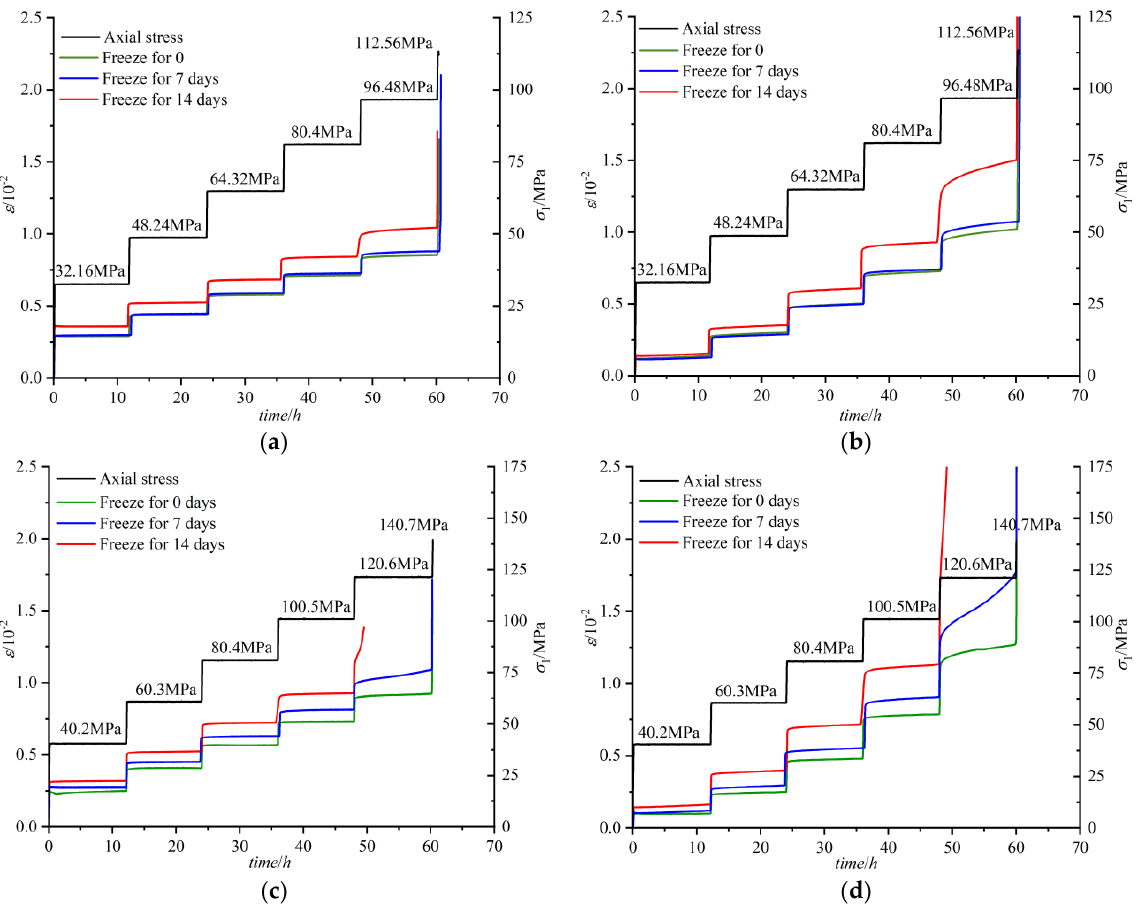
Figure 5. Loading creep curves for different confining pressure and different freezing periods (here, R15-0, R15-7, and R15-14 and R21-0, R21-7, and R21-14 are used to denote rock samples frozen for 0, 7, and 14 days under two types of confining pressure conditions, respectively. and ( a ) initial confining pressure 15 MPa, axial strain curve. ( b ) initial confining pressure 15 MPa, lateral strain curve. ( c ) Initial confining pressure 21 MPa axial strain curve. ( d ) initial confining pressure 21 MPa, lateral strain